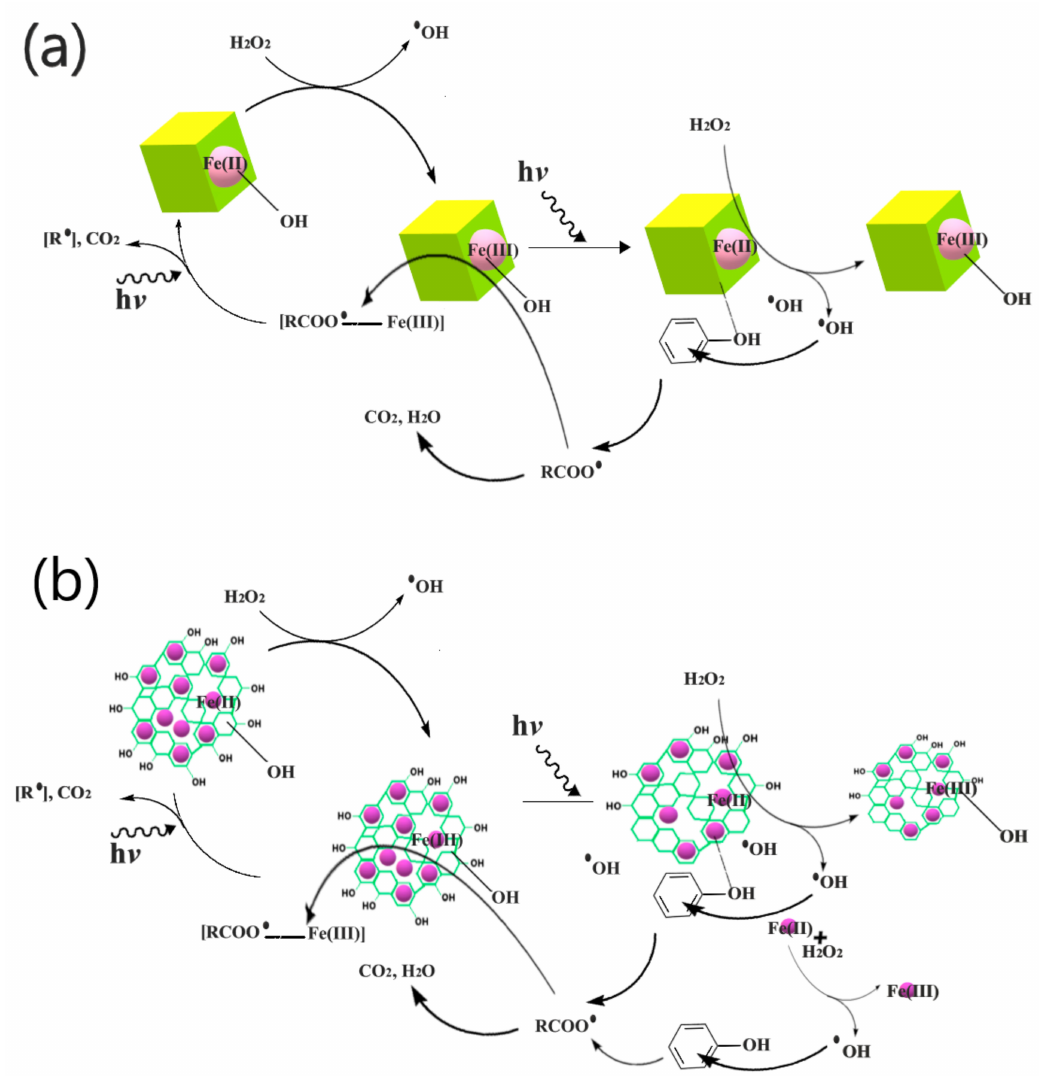
Figure 14. Possible mechanism for the catalytic degradation of phenol on Fe-containing ( a ) zeolites and ( b )